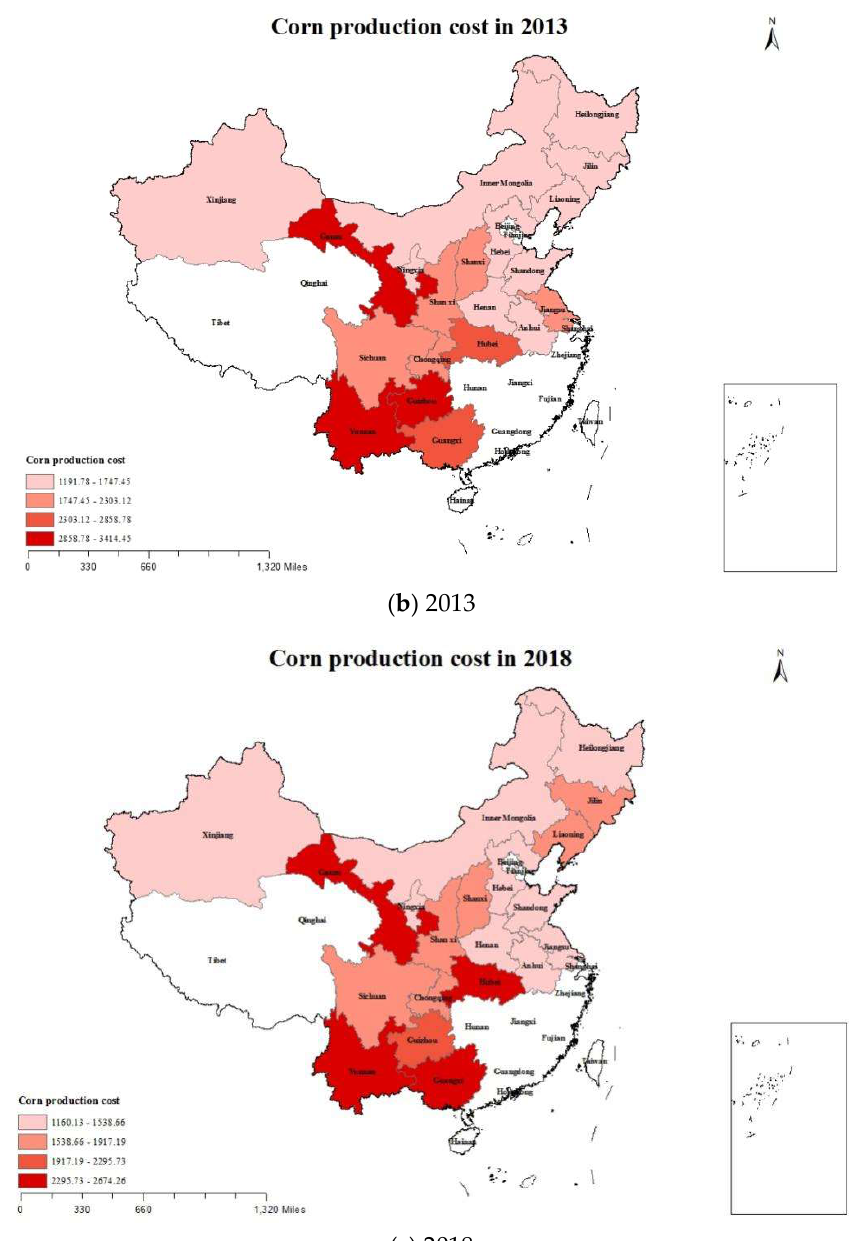
Figure 2. Corn production costs in various regions of China in 2008, 2013 and 2018.